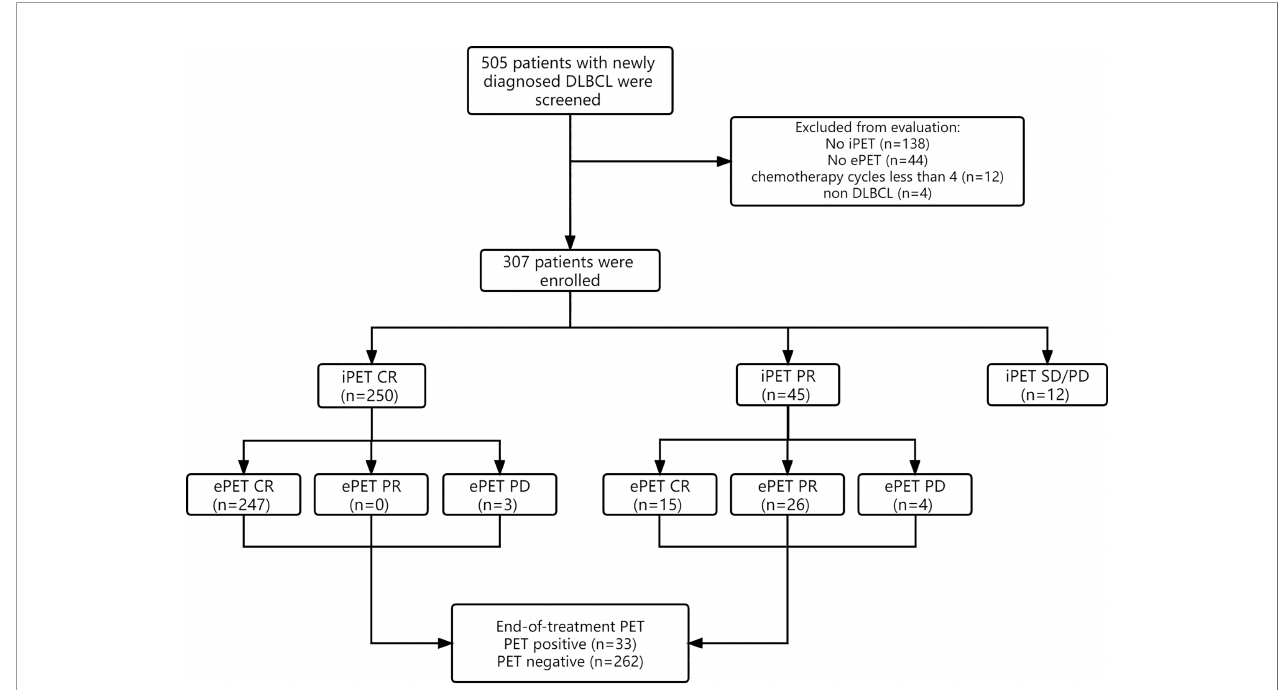
FIGURE 1 | Flow diagram of 505 patients with newly diagnosed DLBCL. 198 patients were excluded from the study, resulting in 307 patients being analyzed. Response evaluation of iPET-CT and ePET-CT were